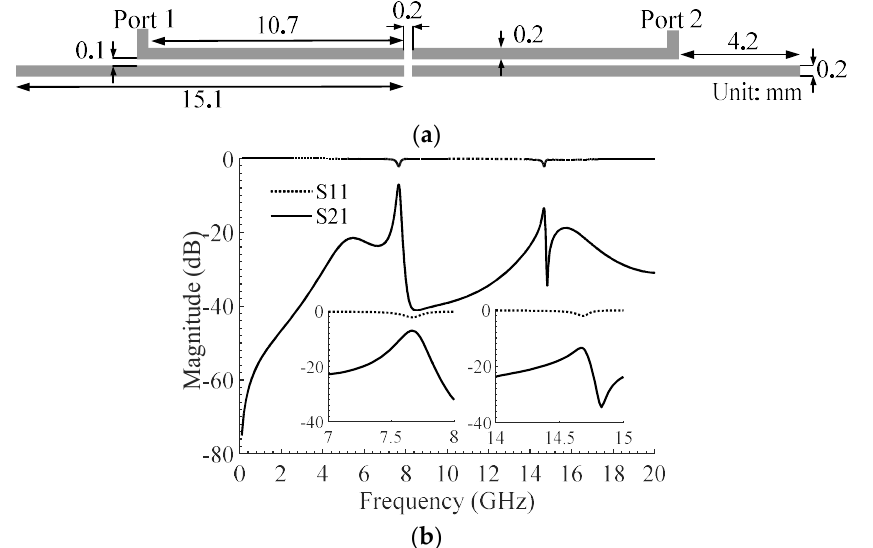
Figure 1. End-coupled transmission line: ( a ) Layout, ( b ) electromagnetic (EM) simulation.